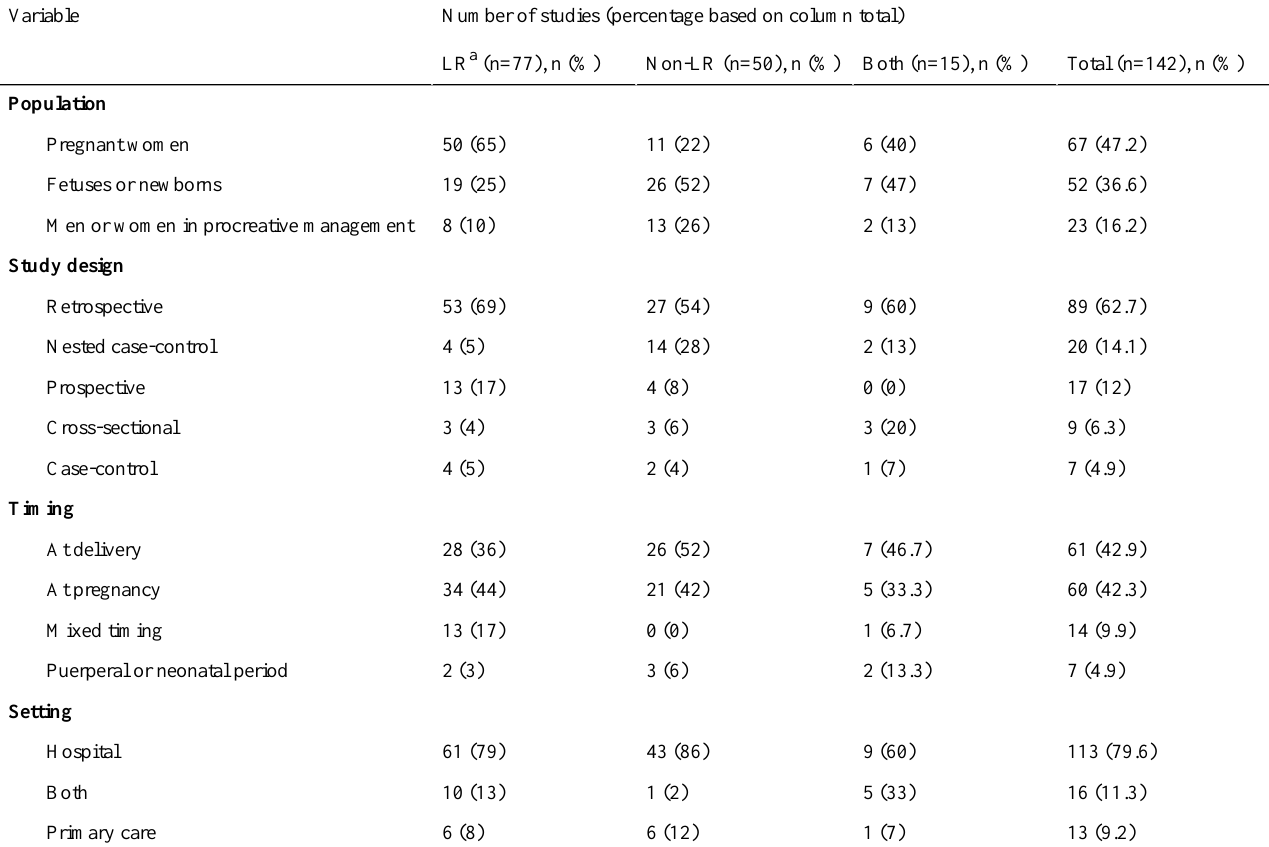
Table 1. Characteristics of eligible studies.